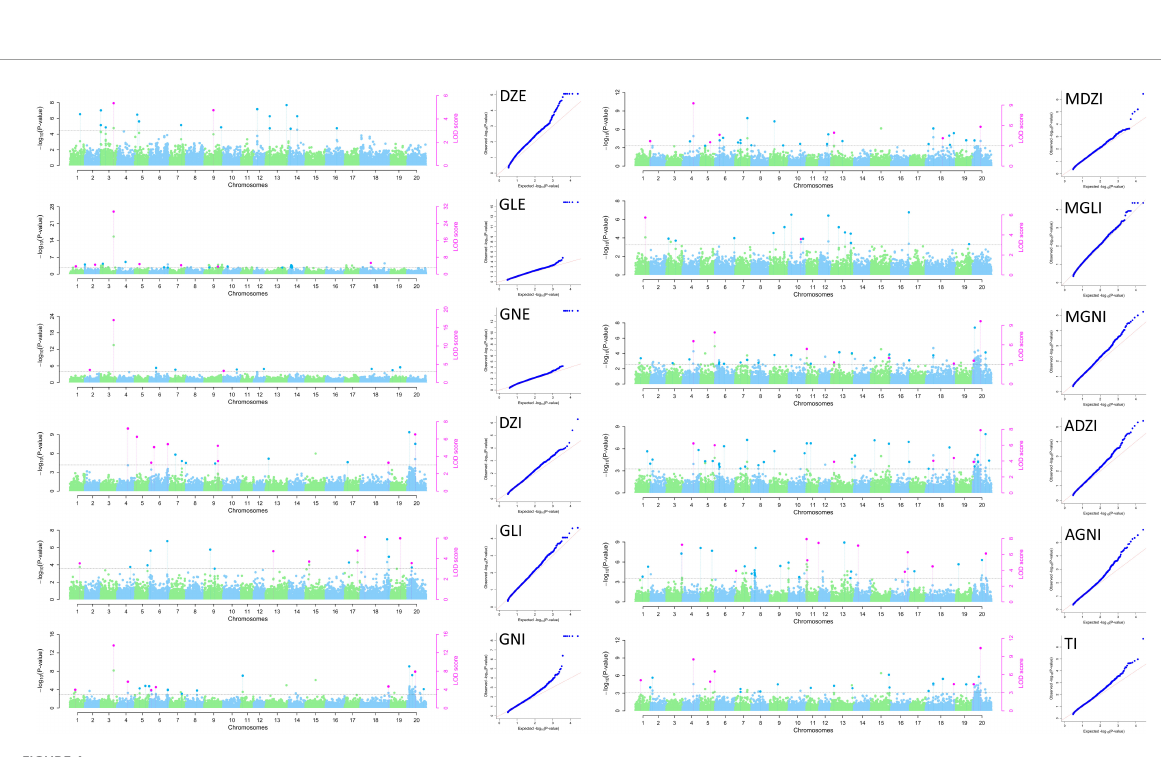
FIGURE4 Manhattan and QQ plots for isoflavone contents in 2021 in the MDP using MLM and mrMLM.